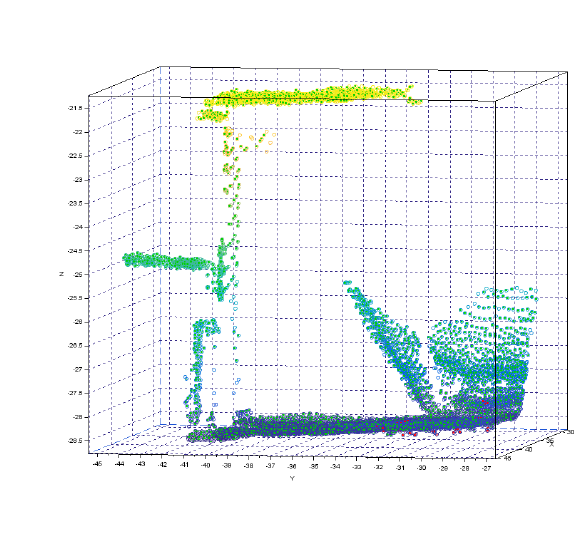
Figure 5. View of the non validated point which seems to be non consistent with the